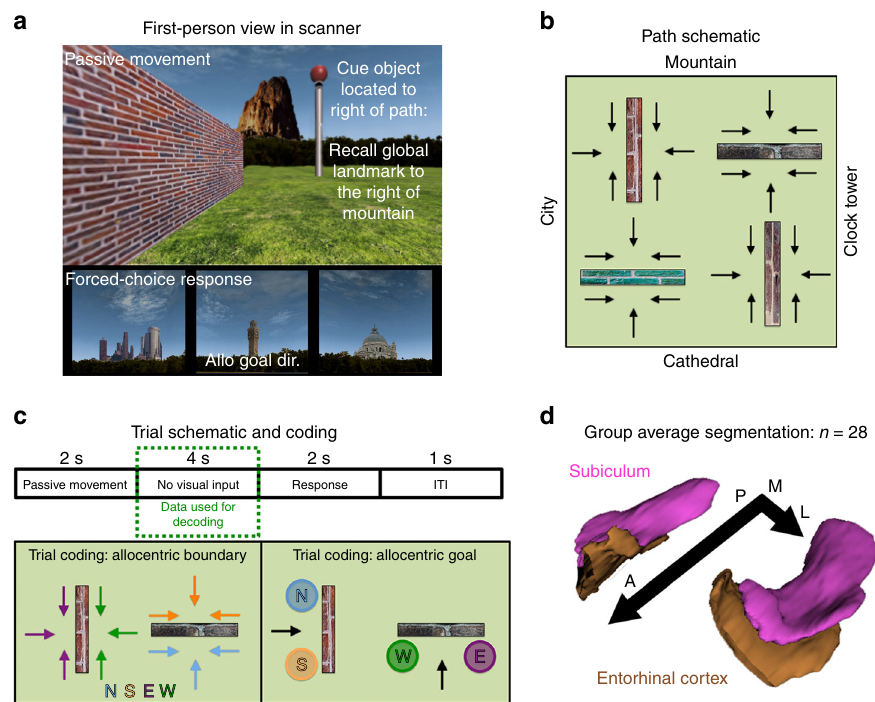
Fig. 4 fMRI scanner task, trial coding and example group ROIs. a On each scan trial, the participant viewed the global landmark towards which they were travelling, a boundary and a cue object (pole with ball). The participant then completed a forced-choice decision in which they were presented with the three other global landmarks (i.e., those not seen during the passive movement) and were required to select the landmark located in the direction of the goal object (correct answer here indicated by “ Allo Goal Dir ” ). b Schematic of the 24 passive paths used in the scan task. Each path was repeated four times resulting in 96 trials per run. c Each trial comprised 2 s of passive movement, four seconds in which the visual input was removed (i.e., the portion of the trial used for the fMRI analysis) and 2 s to make the cue object direction decision. Trials were then coded according to either the allocentric boundary direction or the allocentric goal direction. d All analyses were carried out in the participant ’ s native EPI space using manually segmented masks of the EC and subiculum; the group averaged ROIs are presented here for display purposes